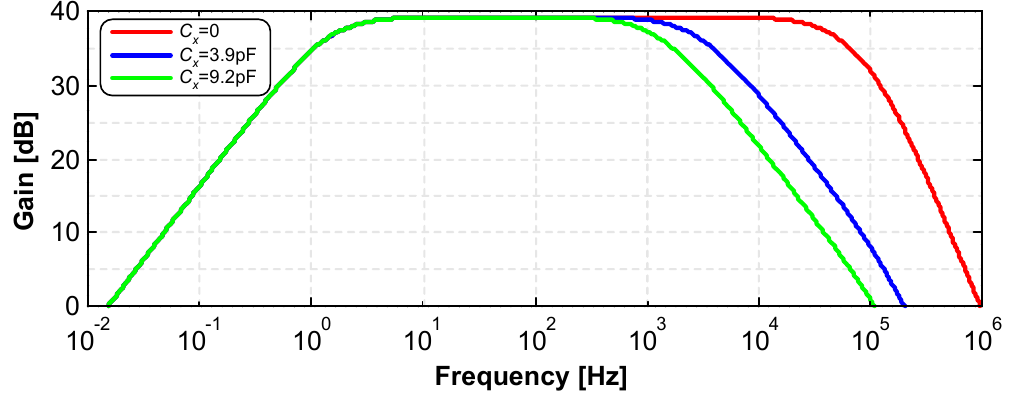
Figure 7. Simulated frequency response of the LNA for C x = 0 ( red trace ), C x = 3.9 pF ( blue trace ), and C x = 9.2 pF ( green trace ).